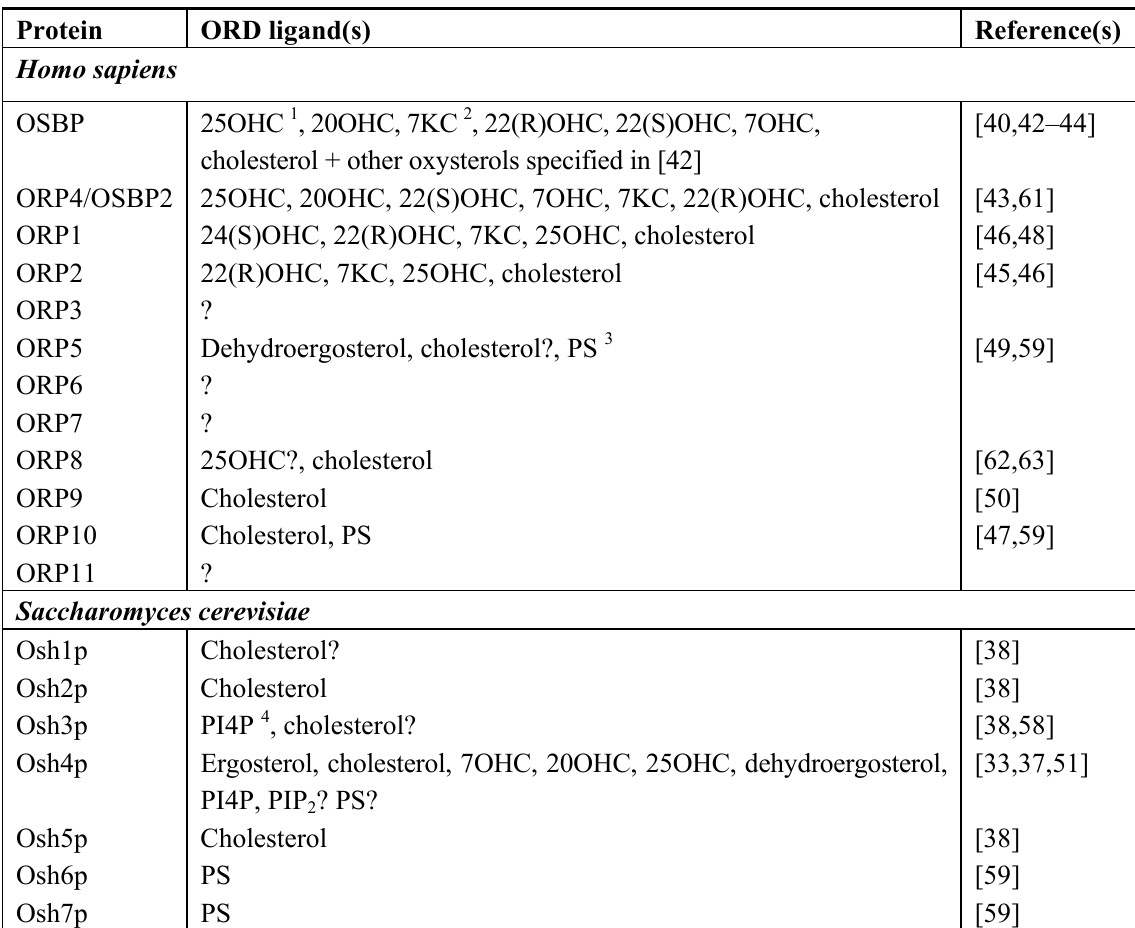
Table 1. Ligands identified for the ORDs of human and Saccharomyces cerevisiae ORPs by structural analyses or in vitro binding/transport